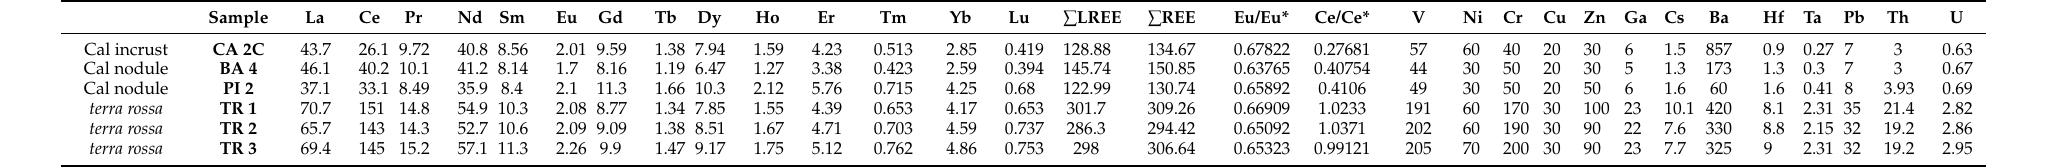
Table 2. Trace elements comprehensive of rare earth elements in selected samples (fusion ICP/MS